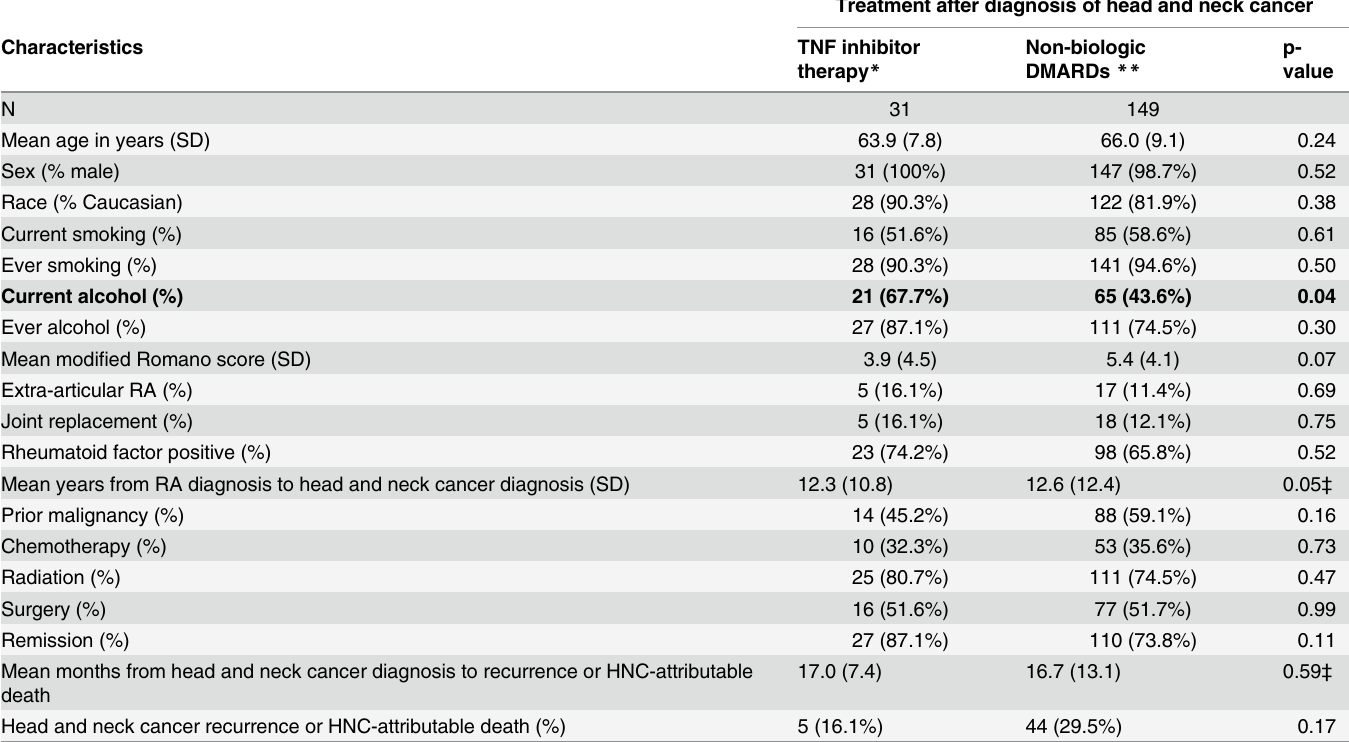
Table 1. Demographic and clinical characteristics of RA patients with head and neck